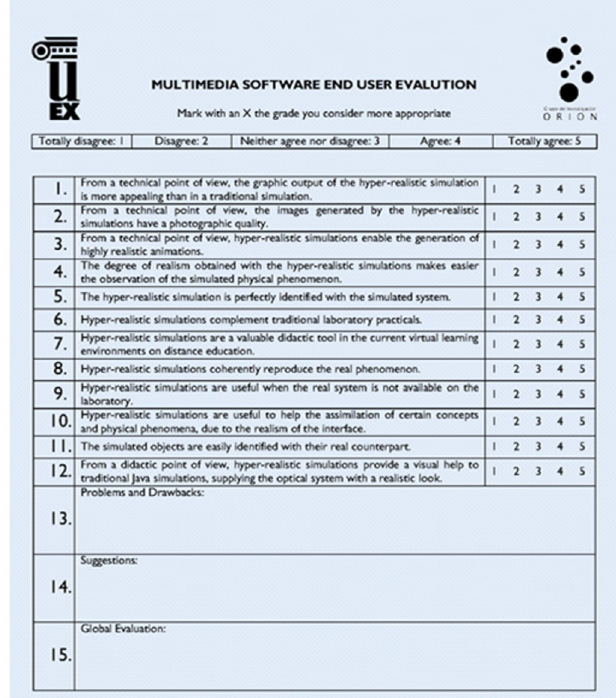
FIG. 8 (color online). Graphical representation of the teachers’ assessment.